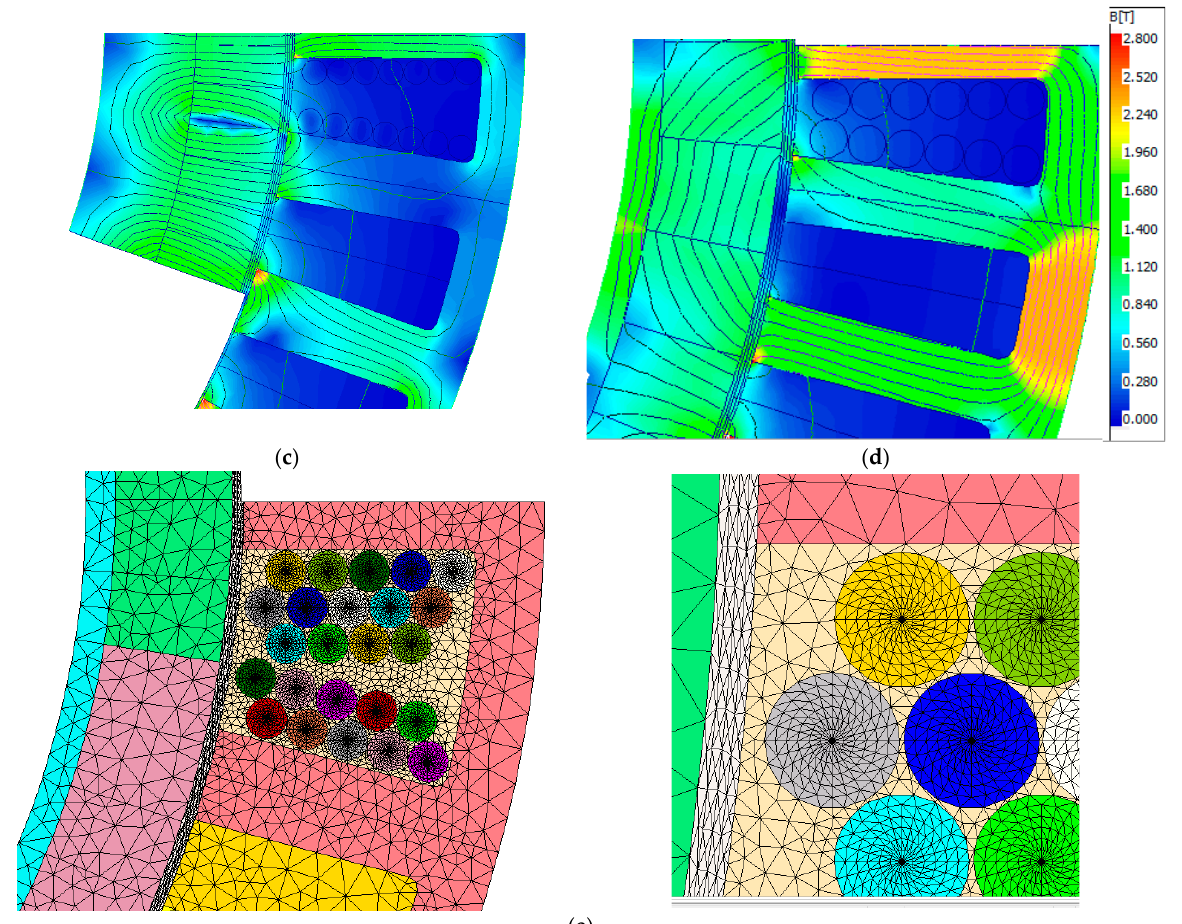
Figure 2. PM magnetisation results, flux density map with the same legend as in ( d ), with the S36-P30 as an example—( a ) parallel with narrow back-iron, ( b ) parallel with wide back-iron, ( c ) radial with wide back-iron, ( d ) Halbach array, ( e ) an example of the conductor’s mesh.